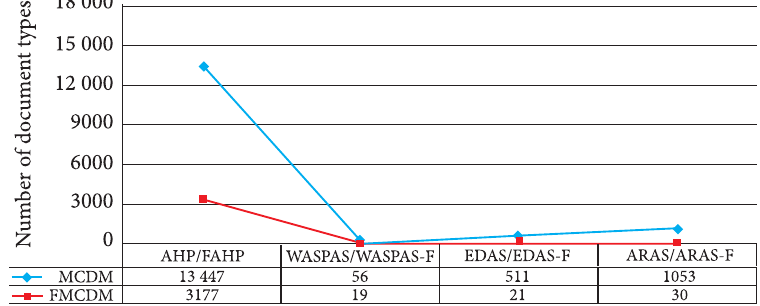
Figure 1. Published documentary using MCDM & FMCDM methods over years considering their abstracts, keywords and